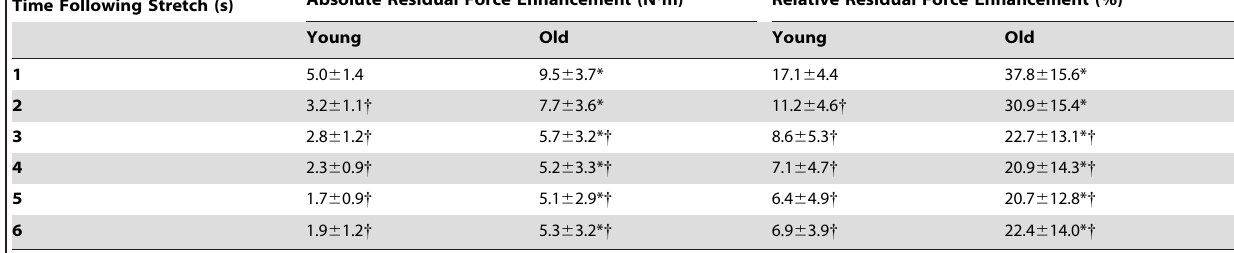
Table 3. Residual force enhancement